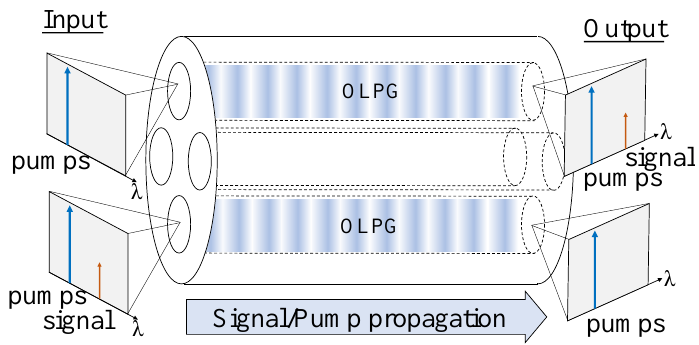
Figure 1. Schematic of the OLPG-based core switch. Pumps are launched in two modes at the input of the MCFs in two cores, inducing OLPGs. When two cores have similar OLPGs, the signal is transferred from the input to the